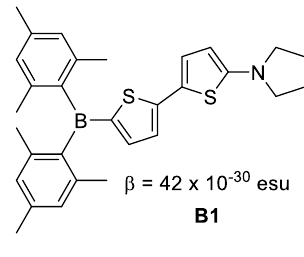
Figure 6. Boron in neutral form. Figure 7. Boron in ionic form.